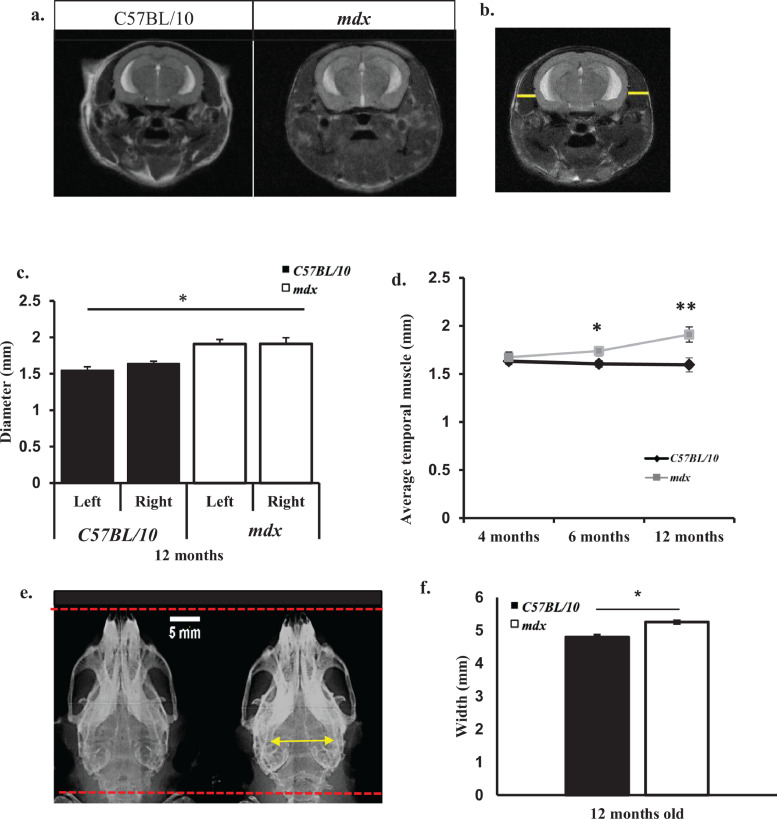
a–e: Bilateral temporal muscle hypertrophy in mdx mice. a. Representative T2-weighted coronal images showing changes in head shape of the mdx mouse. There is hypertrophy of the temporal muscle in mdx mice causing a change in head shape compared to age matched control mice. b. Representative image demonstrating temporal muscle thickness measurements (yellow lines). c. There is bilateral temporal muscle hypertrophy in mdx mice at 12 months old compared to aged matched control mice. d. Evolution of the temporal muscle thickness (averaged values for left and right) with age in control and mdx mice e. Representative radiographs of the mouse skull aged 12 months old (n = 4 mice per genotype). Yellow arrow represents widening of the squamosal bones. f. Bar graph displaying the widening of the squamosal bones in mdx mice at 12 months old compared to aged matched control mice (p<0.05). Data are presented as mean ± SEM, *p < 0.05, **p < 0.01 for control vs. mdx mice, n = 8 mice per genotype at each time point unless otherwise stated.